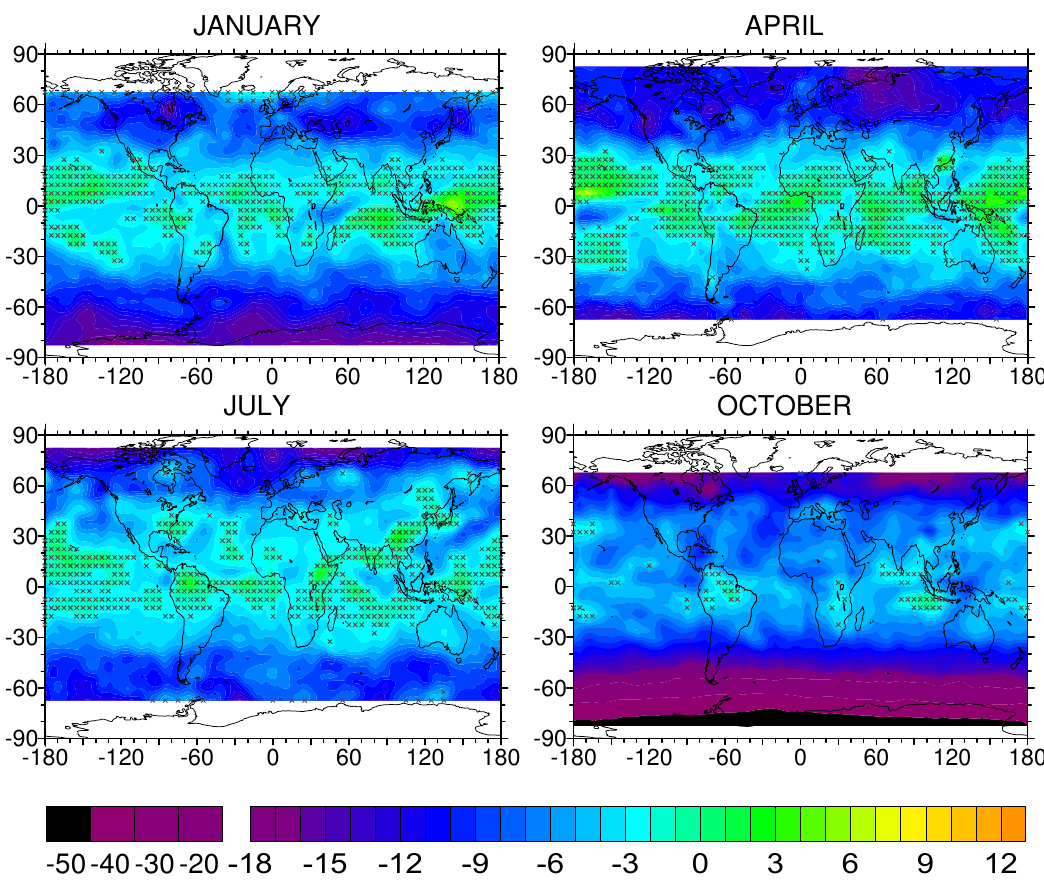
Fig. 3. Multi model mean changes (%) in UV-Ery under all-sky conditions. Changes are given for monthly means averaged over the period 2045–2054 relative to 1995–2004. Crosses mark areas where changes are not statistically significant at the 95% level. Note the change in colour scale for reductions larger than 20%.